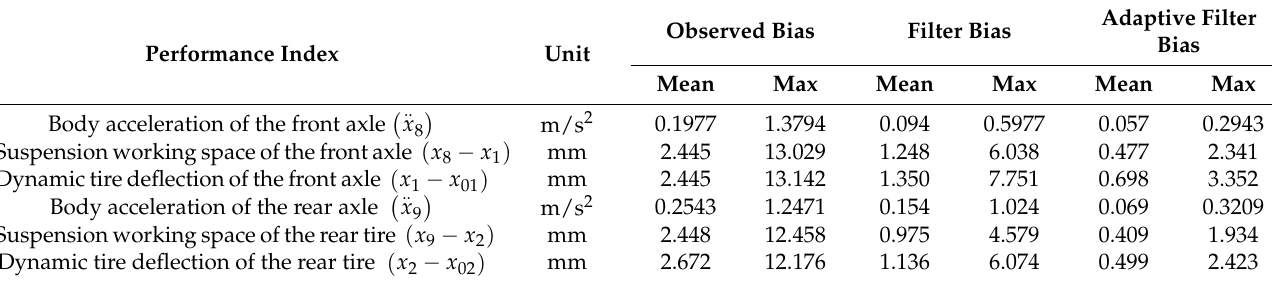
Table 6. Kalman filter bias values of measurable performance indexes.